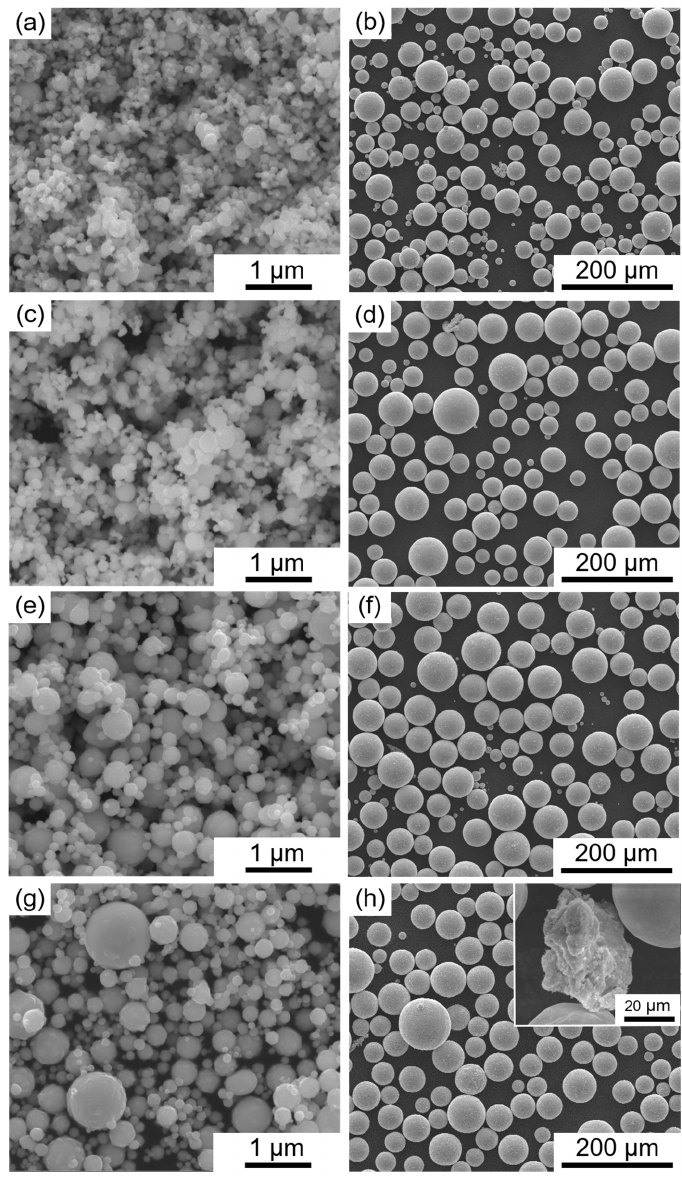
Figure 2. SEM images of the NP-powder and CS-powder with different powder feed rates: ( a ) and ( b ) 1.5 g/min, ( c ) and ( d ) 3.5 g/min, ( e ) and ( f ) 5.5 g/min, ( g ) and ( h ) 7.5 g/min.